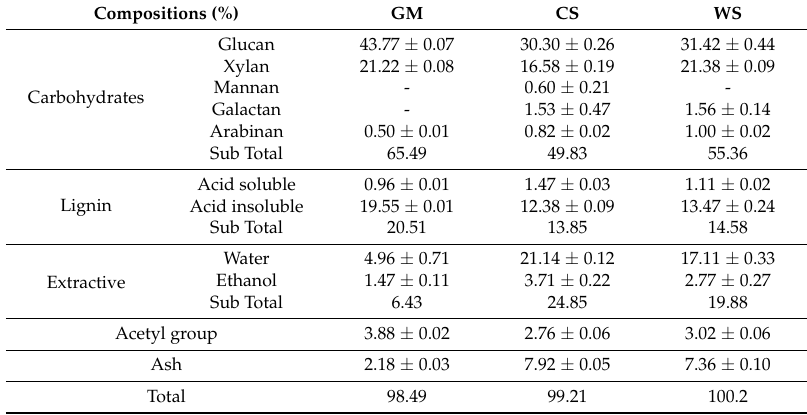
Table 1. Compositions of the three types of herbaceous biomass used in this study. GM: Giant Miscanthus; CS: corn stover; WS: wheat